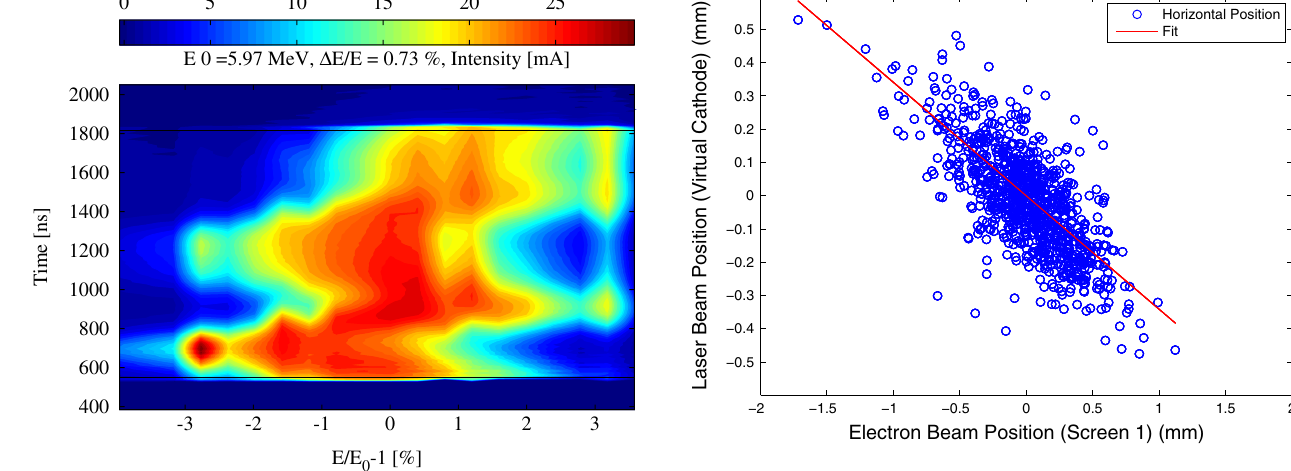
FIG. 15. The time-resolved energy and energy spread mea- surement by the segmented dump. The contour plot of the energy change during the 1300 ns electron beam hitting the segmented